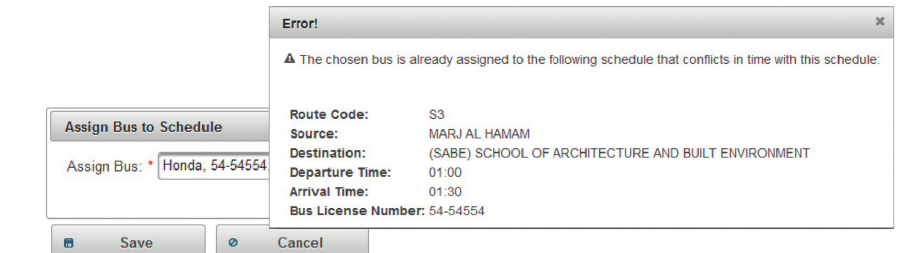
Figure 17: The conflict detection message when attempting to assign a bus to an overlapping